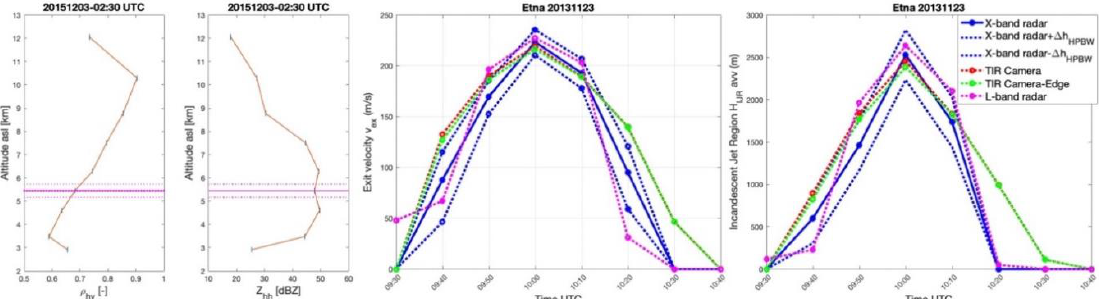
Figure 7. On the left: horizontally averaged vertical profile at the specific time of the copolar correlation coe ffi cient ρ hv (adim) and the reflectivity factor Z hh (dBZ) during the explosive activity on 23 November 2013 at 10:10 UTC. The brown line identifies the mean value, whereas the small horizontal blue bars correspond to the standard deviations computed at each altitude related to radar elevation angles above the vent. The magenta line identifies the altitude where the algorithm, at the specified time, simultaneously maximizes Z hh and minimizes as much as possible ρ hv , whereas the two dashed magenta lines quantify the altitude variability range. In the middle and on the right panels, we show the time-series having a time step of 10 min of v ex and H IJR respectively. The H IJR is directly extracted from two TIR camera approaches, TIR Camera and TIR Camera-Edge, and the L-band and X-band radar, latter expressed as in function of the uncertainty ∆ h HPBW (about 300 m) correlated to half-power beam width of X-band radar.